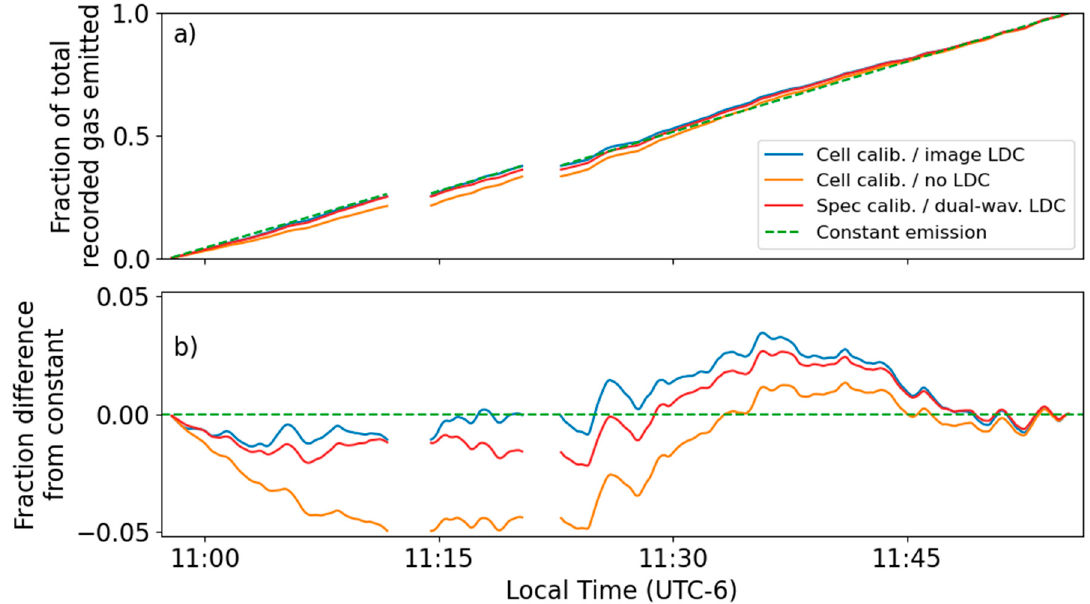
Figure 9. ( a ) The cumulative fraction of the total SO 2 emission measured by each technique on the 15 January 2018 through each camera frame. Uncorrected (orange), cell-calibrated image-based corrected (blue) and spectrometer-calibrated dual-waveband corrected (red) techniques are presented. Additionally shown is a theoretical constant gas emission through time (green dashes). ( b ) The difference between the three techniques in ( a ) and the constant gas emission line.